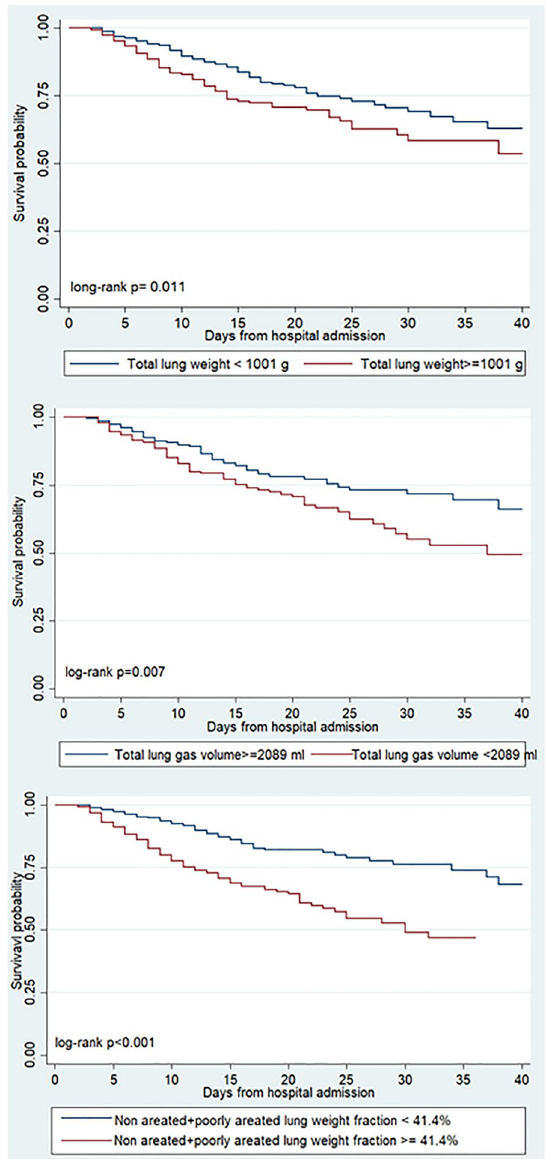
Fig. 2 Kaplan–Meier curves according to lung tissue weight (under and above or equal to 1001 g, A ), to lung gas volume (under and above or equal to 2089 ml, B ) and to not aerated plus poorly aerated fraction (under and above or equal 41.4%, C ). The probability of in-hospital death was assessed by log-rank